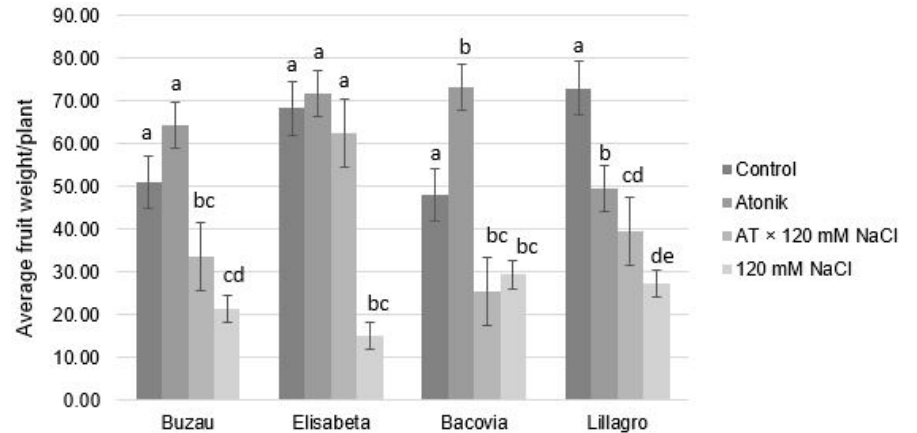
Figure 6. The effect of Atonik biostimulant on the average fruit weigh per plant under saline stress after the third treatment. Different letters mean significant differences, according to the Tukey test. Error bars indicate ±SD.